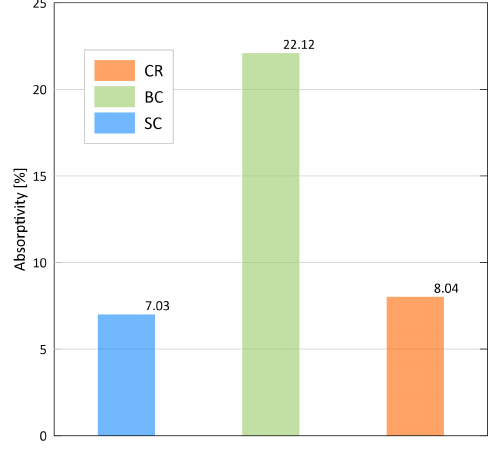
Figure 10. Water